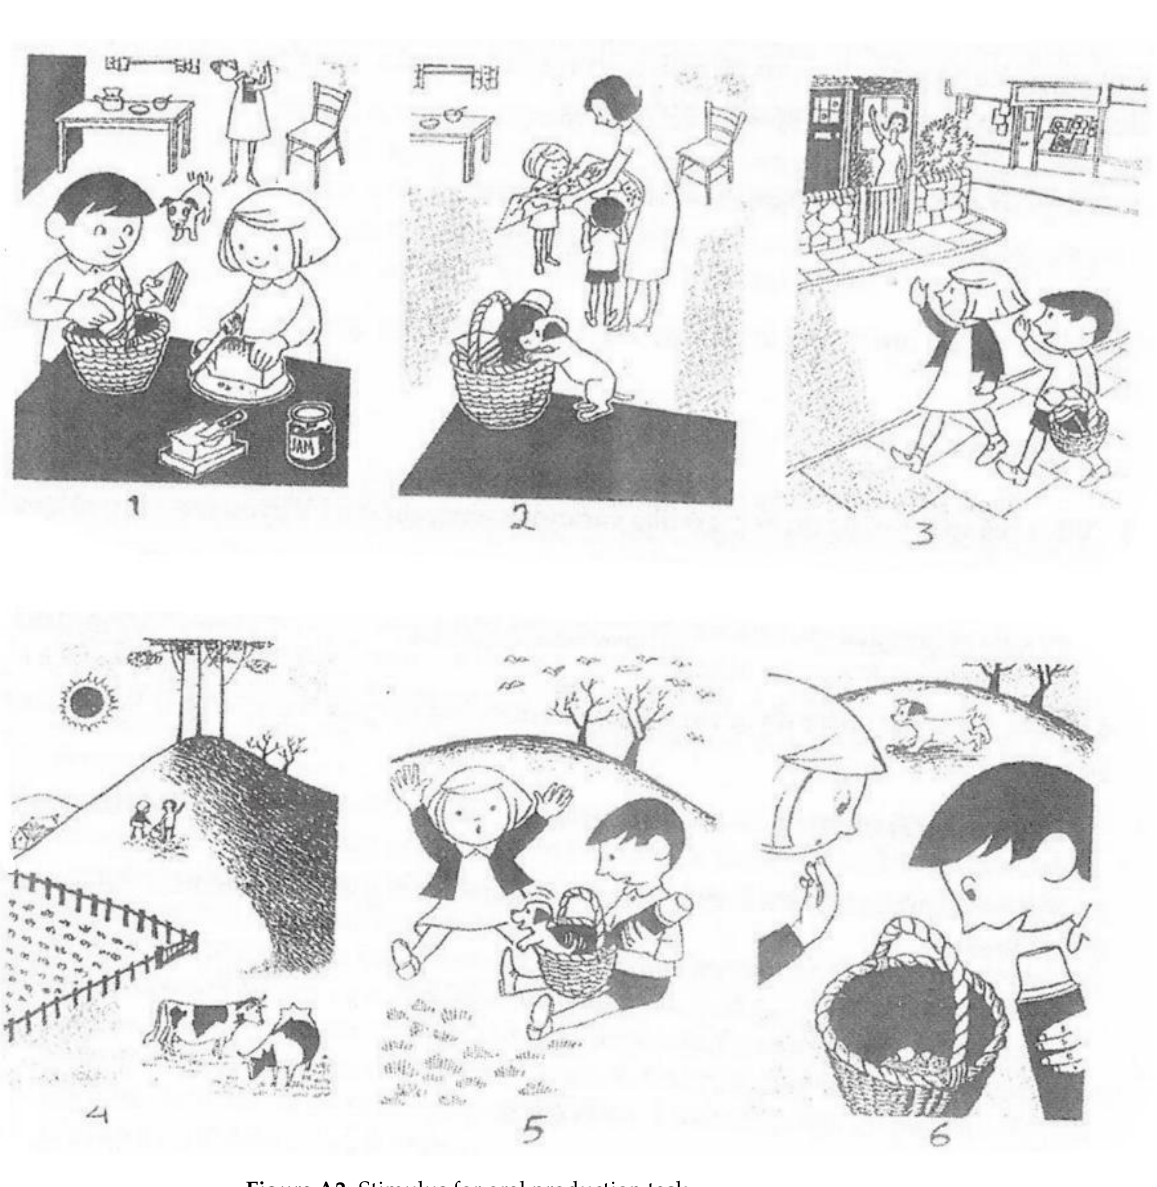
Figure A2. Stimulus for oral production task.